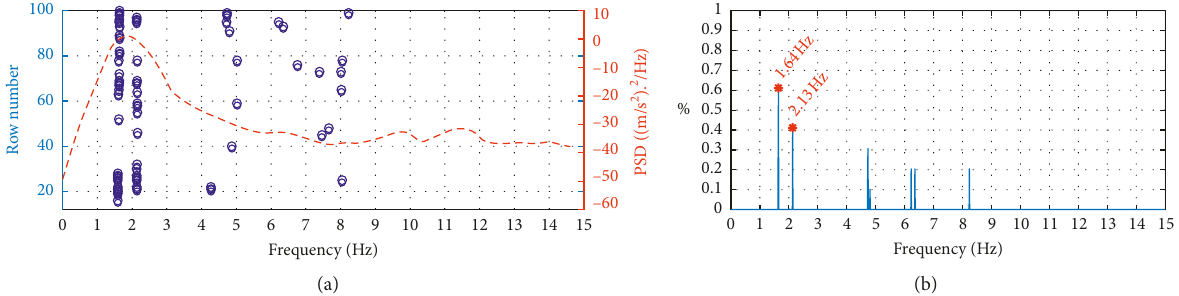
FL. (b) Ch FR. (c) Ch RL. (d) Ch RR. (cid:31) (cid:31) (cid:31) (cid:31)